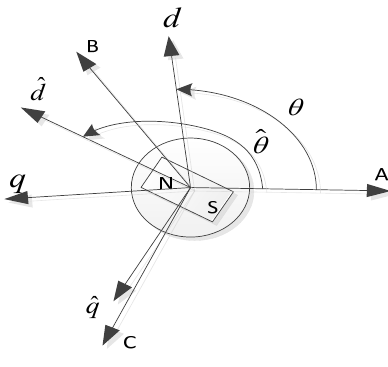
Figure 3. Model of a SPMSM with definition of the used